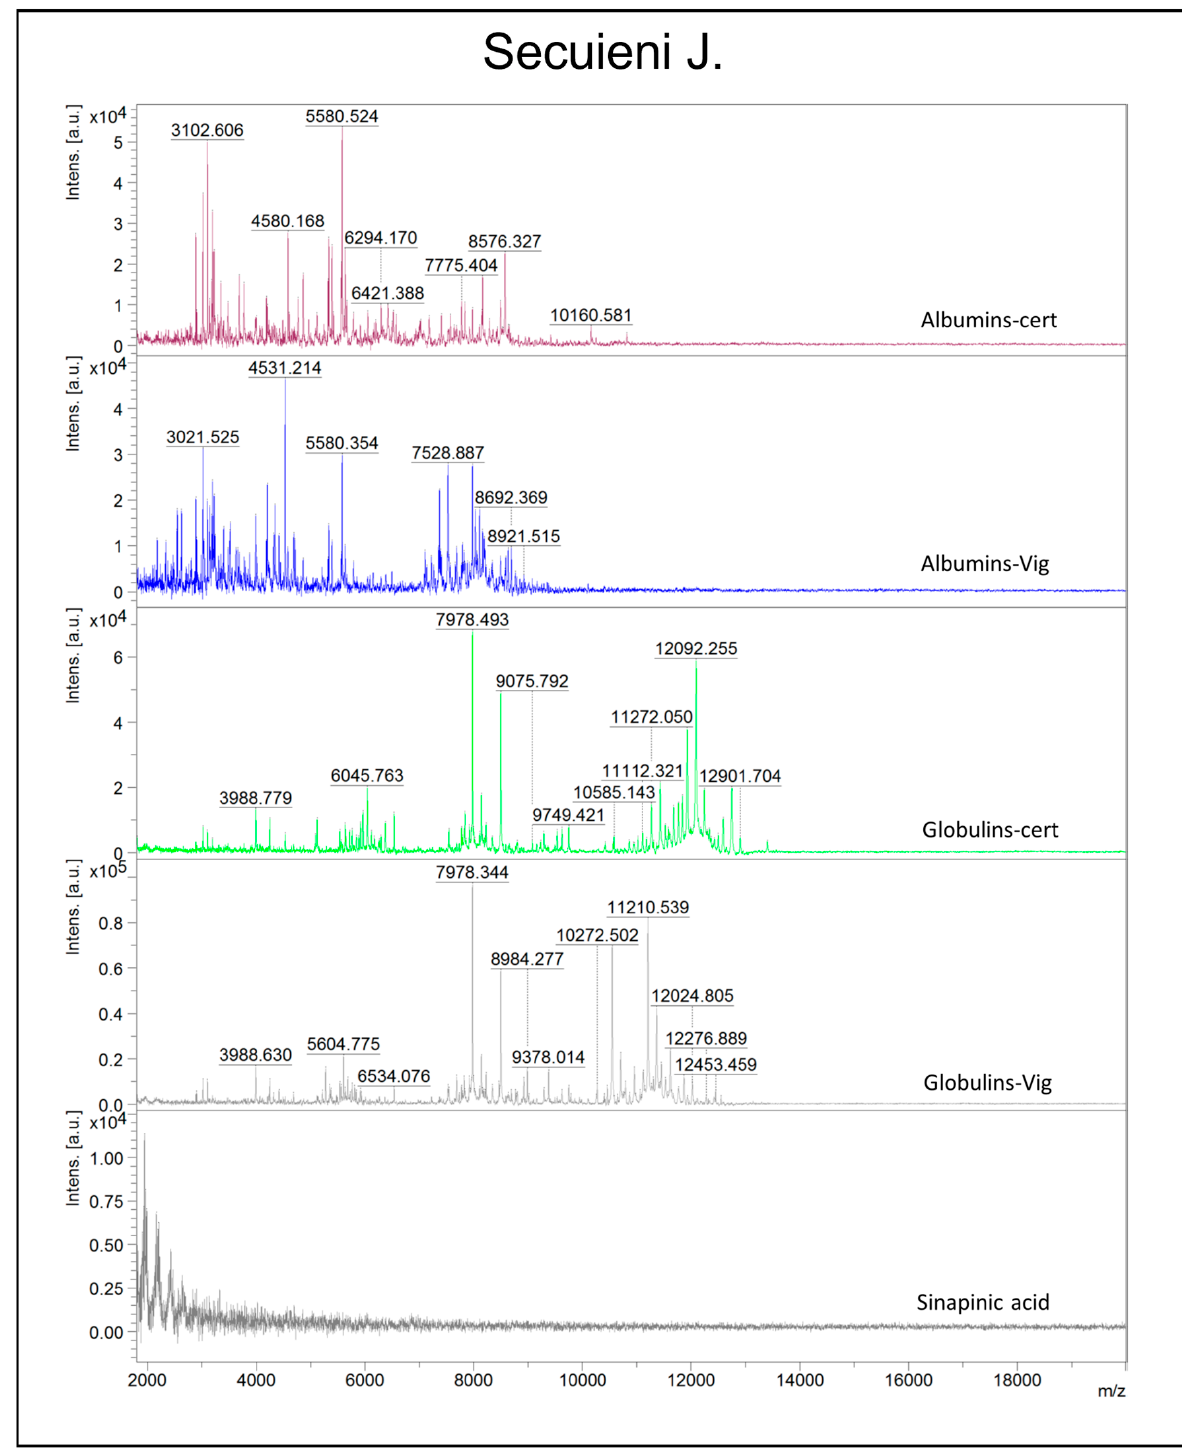
Figure 4. Representative MALDI-TOF MS spectra in the m/z region 2000–20,000 obtained for protein extracts (albumins/globulins) of Secuieni J. seeds from commercial source (cert) or experimental field (Vig). The mass spectrum of the matrix (sinapinic acid) is also presented as reference.